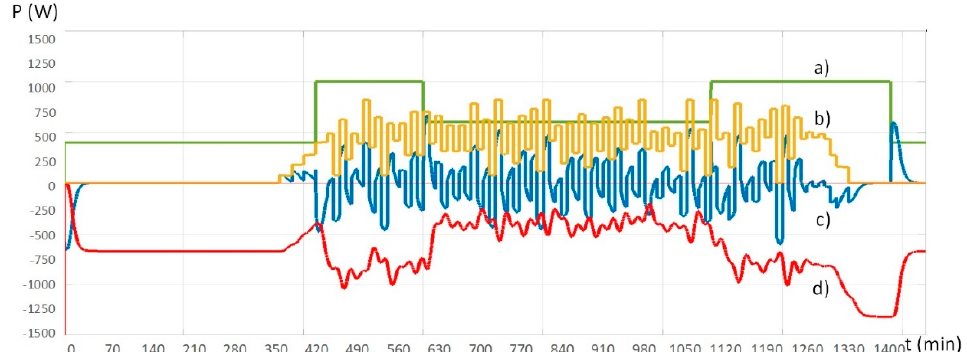
16 of 24 Figure 14. Simulation process for sunny day conditions. Storage system filter with damping ratio